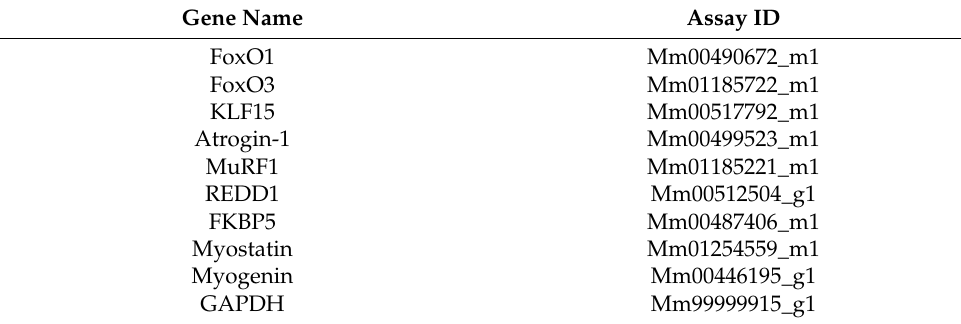
Table 1. Taqman probes were used in the present